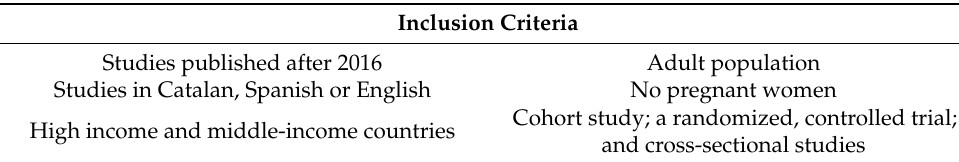
Table 1. Inclusion criteria considered for the selection of